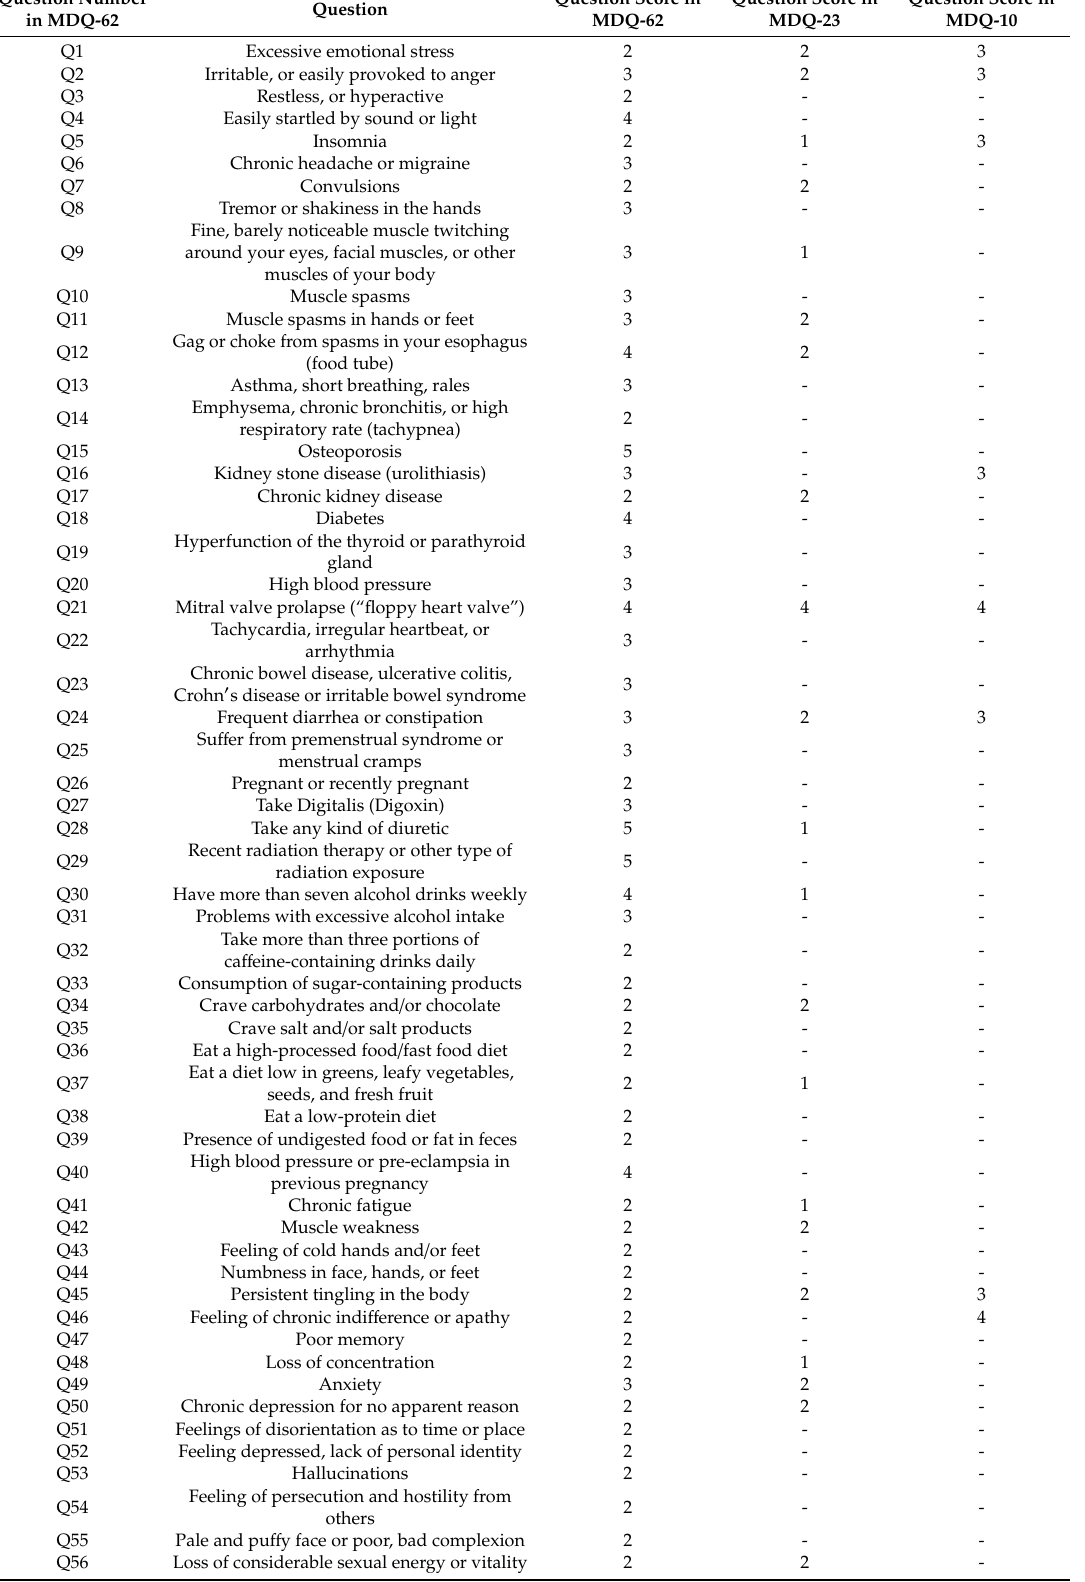
Table 4. Initial (MDQ-62) and modified (MDQ-23, MDQ-10) questionnaires with individual questions (cid:48)